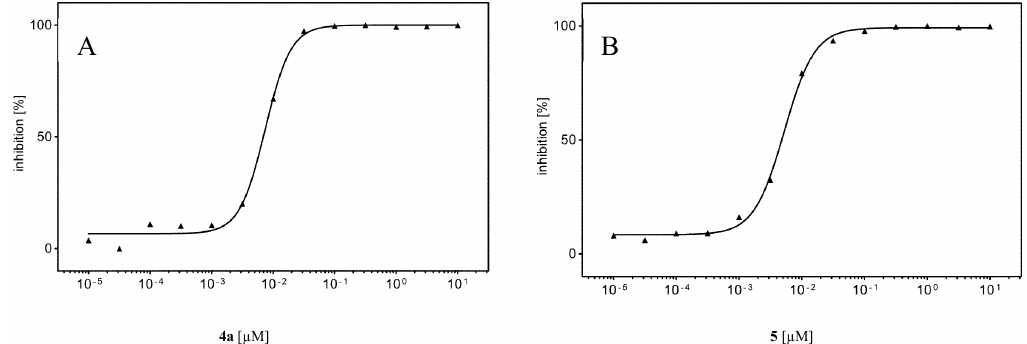
Figure 2. Dose-response curves for the determination of IC 50 values of 4a ( A ) and 5 ( B ). Human protein kinase CK2 holoenzyme was pre-incubated for 10 min with 13 different concentrations of each compounds ranging from 0.01 nM to 10 µ M before the enzymatic activity was determined. The residual activity was set into relation of the activity of the enzyme without added compounds but with the same volume of DMSO, which was taken as 100%. The resulting inhibition in % was set into relation to the concentration of the corresponding compound in a logarithmic scale. For the calculation of the sigmoidal curve fitting the date GraphPad Prism (GraphPad, La Jolla, CA, USA) was used, as well as for the compound concentrations corresponding to 50% enzyme inhibition. The IC 50 values determined this way turned out to be 7 nM for 4a and 5 nM for 5 .